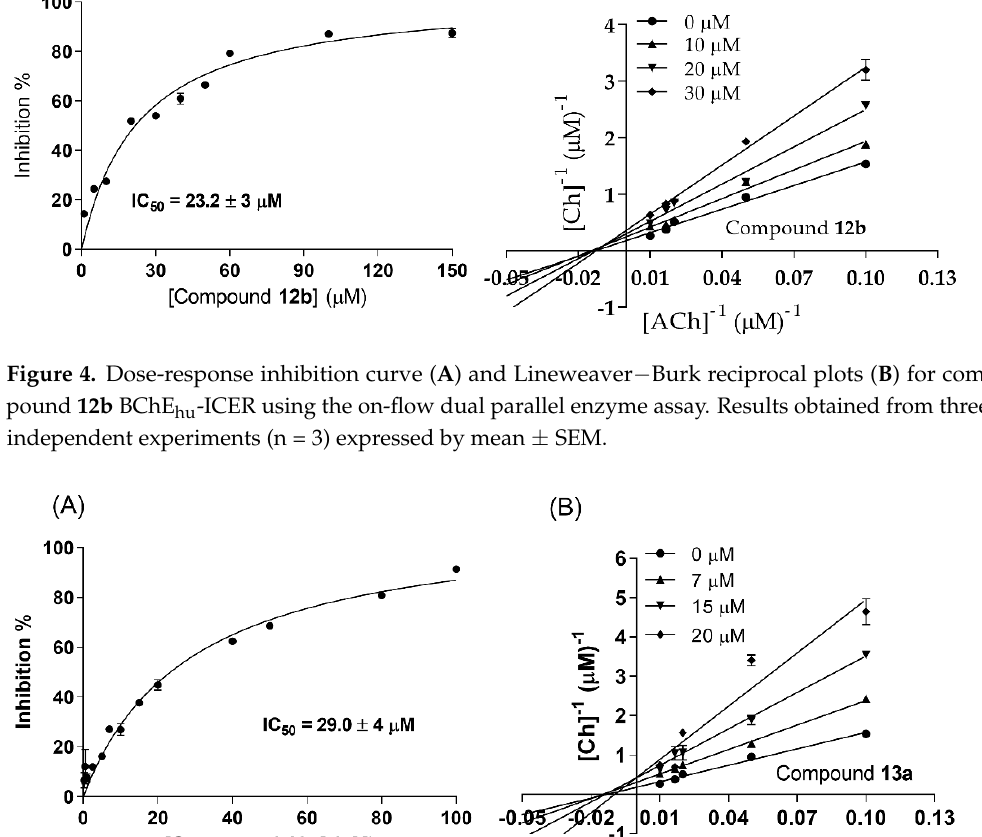
Figure 5. Dose-response inhibition curve ( A ) and Lineweaver − Burk reciprocal plots ( B ) for com- pound 13a BChE hu -ICER using the on-flow dual parallel enzyme assay. Results obtained from three independent experiments (n = 3) expressed by mean ±